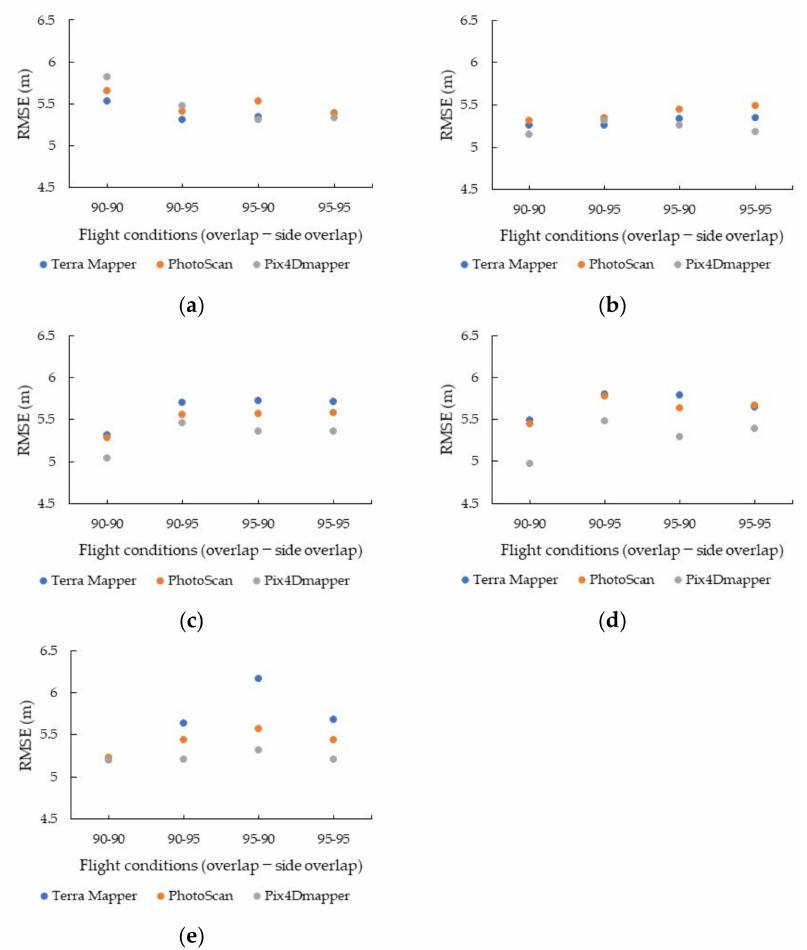
Figure 9. RMSE (root mean square error) of the estimated tree height results by each SfM software: ( a ) flight altitude = 60 m; ( b ) flight altitude = 80 m; ( c ) flight altitude = 100 m; ( d ) flight altitude = 120 m; and ( e ) flight altitude = 140